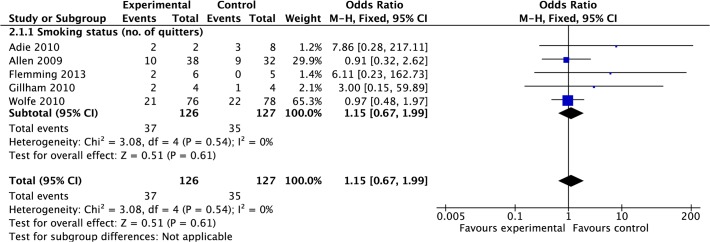
Forest Plot: Smoking.